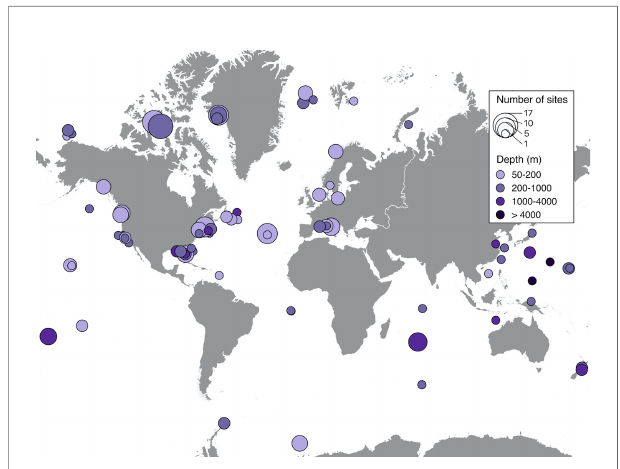
FIGURE 4 | Spatial distributions of recordings extracted from published studies on ocean soundscapes (see Supplementary Material for data sources) recorded at depths greater than 50 m. Closed circles on the map represent areas where soundscape recordings were obtained, with the size of the symbol being proportional to the number of sites of each recording, and the color indicating the depth range of the recording.